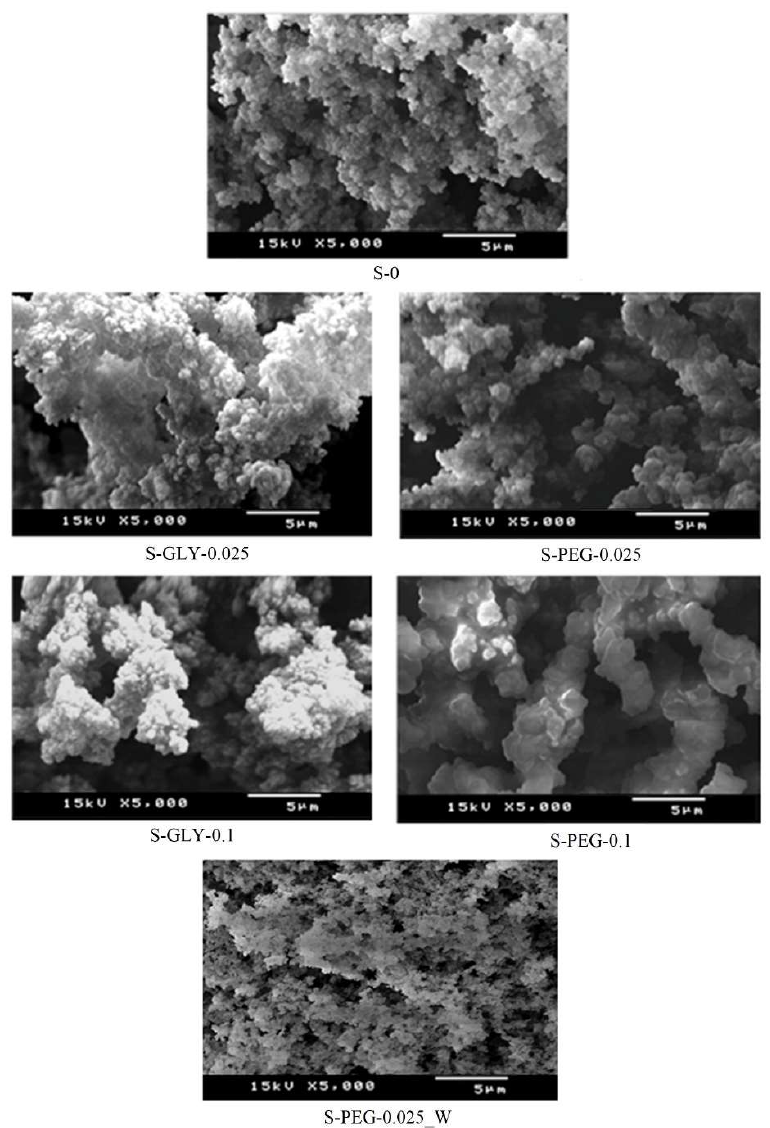
Figure 5. SEM images of the typical microstructures of the aerogel-like materials synthesized with and without additives.